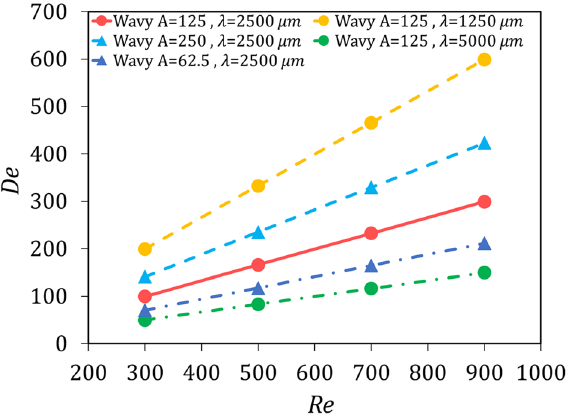
Figure 14. Dean number versus Reynolds number.